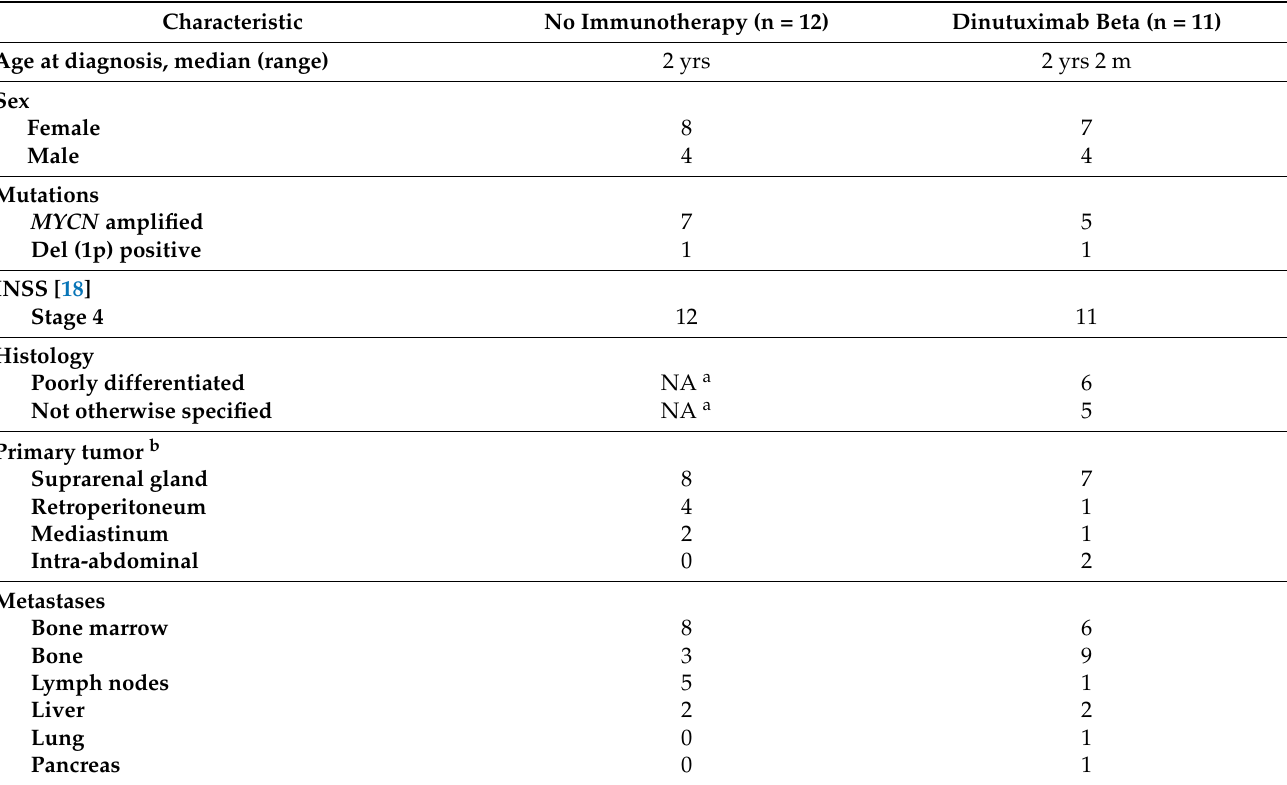
Table 1. Summary of disease characteristics for all 24 patients with high-risk neuroblastoma treated with or without